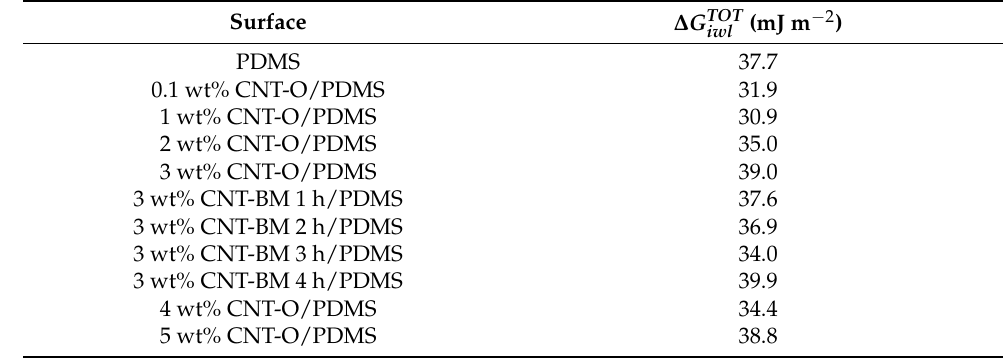
Table 3. Free energy of adhesion ( ∆ G TOT when immersed in water ( w ).